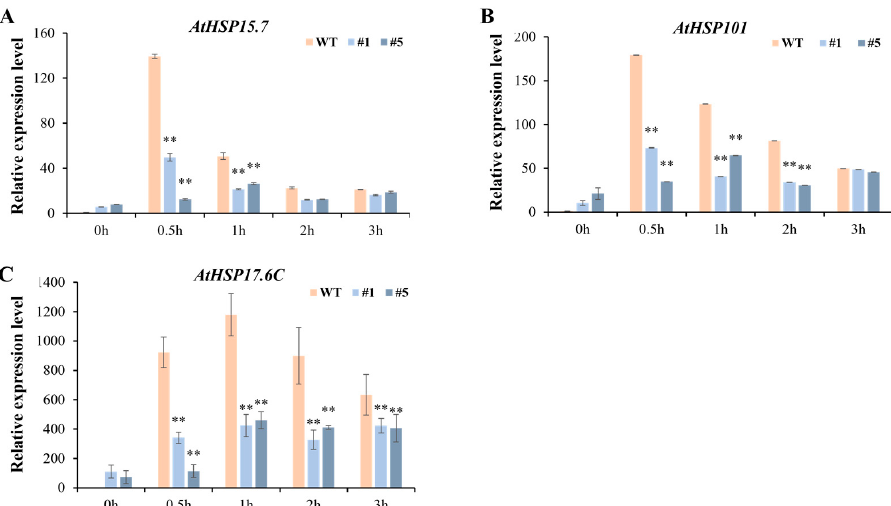
Figure 7. The expression level of AtHSPs genes in CmHSP90.5 transgenic Arabidopsis and Col-0 plants after heat treatment. The expression level of AtHSP15.7 ( A ), AtHSP101 ( B ), AtHSP17.6 ( C ) was measured after heat treatment. The Arabidopsis AtActin2 gene was used as the reference gene. Error bars represent ± SE. ** Statistically significant differences were compared with Col-0 plants under different conditions. Value of p < 0.01 was considered to be statistically significant.